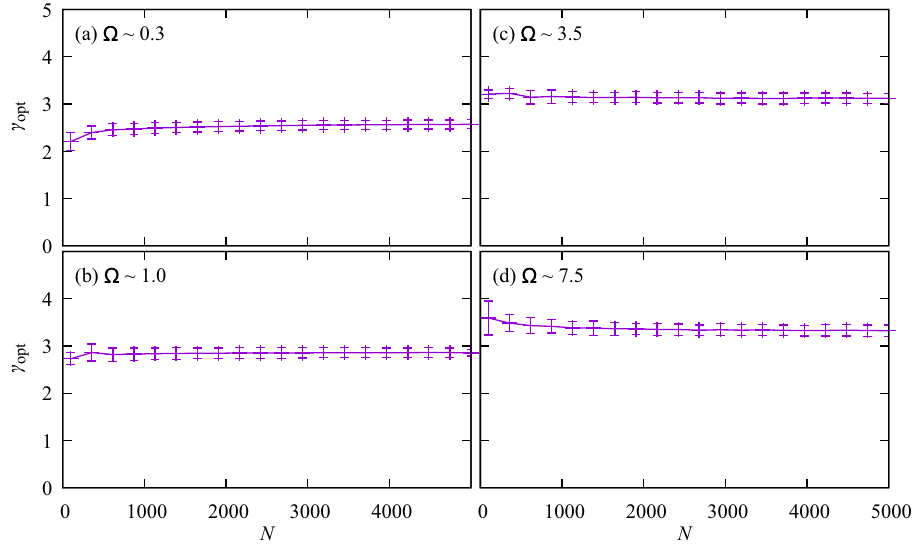
Figure 10. Sensitivity of γ opt to uncertainty in (cid:31) is found to be less than 10% for various (cid:31) and N